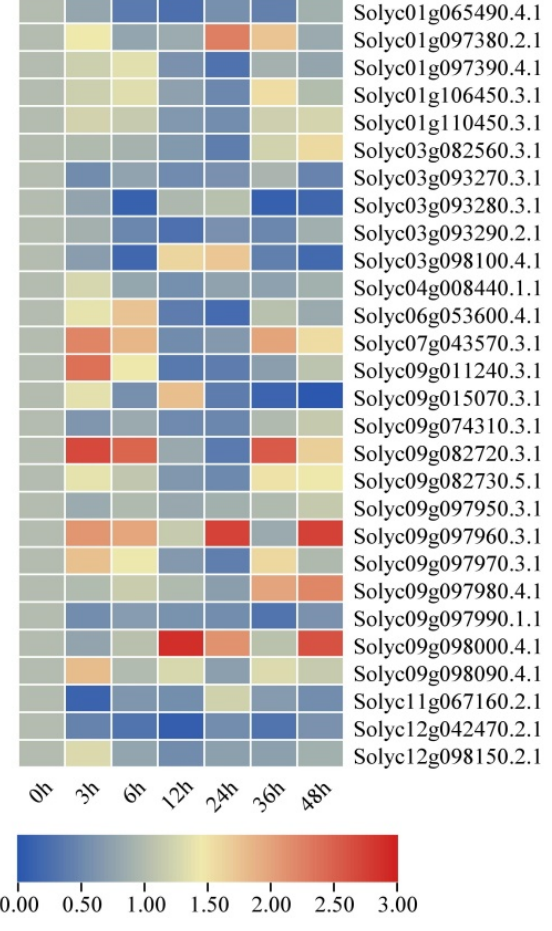
O as a control in AC. 2